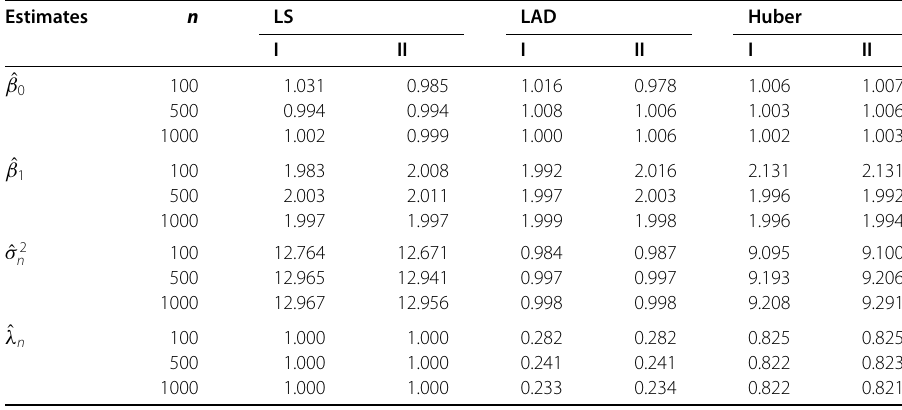
Table 1 The evaluations of regression coefficients and redundancy parameters Estimates n